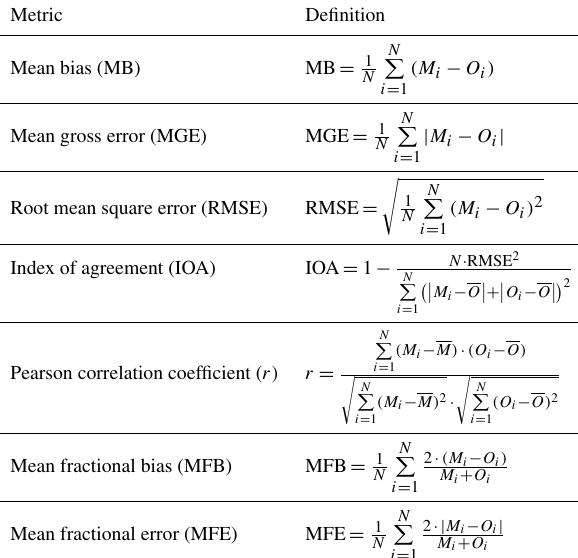
Table 1. Definition of statistical metrics for model performance evaluation. M i and O i stand for modeled and observed values, re- spectively, and N is the total number of paired